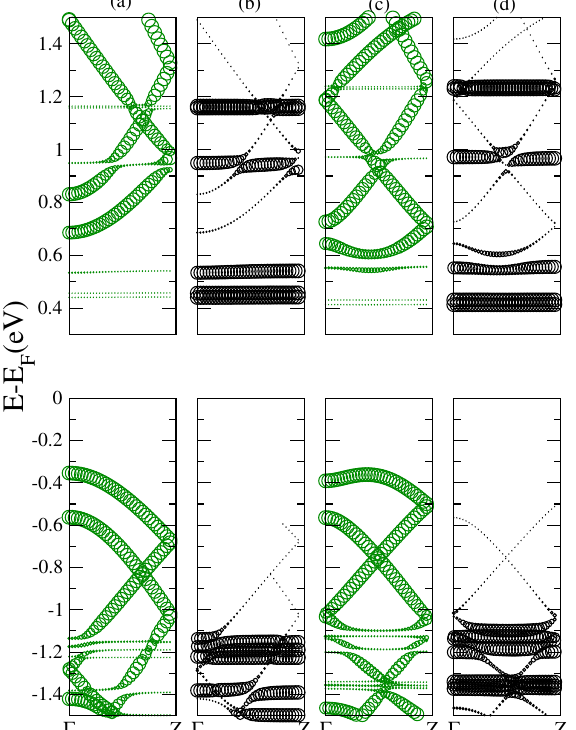
Figure 7. Fat-band representation for the band structure of the complex 10GR–C 70 . Columns ( a ) and ( b ) are for a null electric field and columns ( c ) and ( d ) for an electric field of 0.5 V/Å. Columns ( a ) and ( c ) show the contribution of the 10GR carbon atoms and columns ( b ) and ( d ) the contribution of the C 70 carbon atoms to the band structure. Upper panels correspond to conduction bands and lower panels correspond to the valence